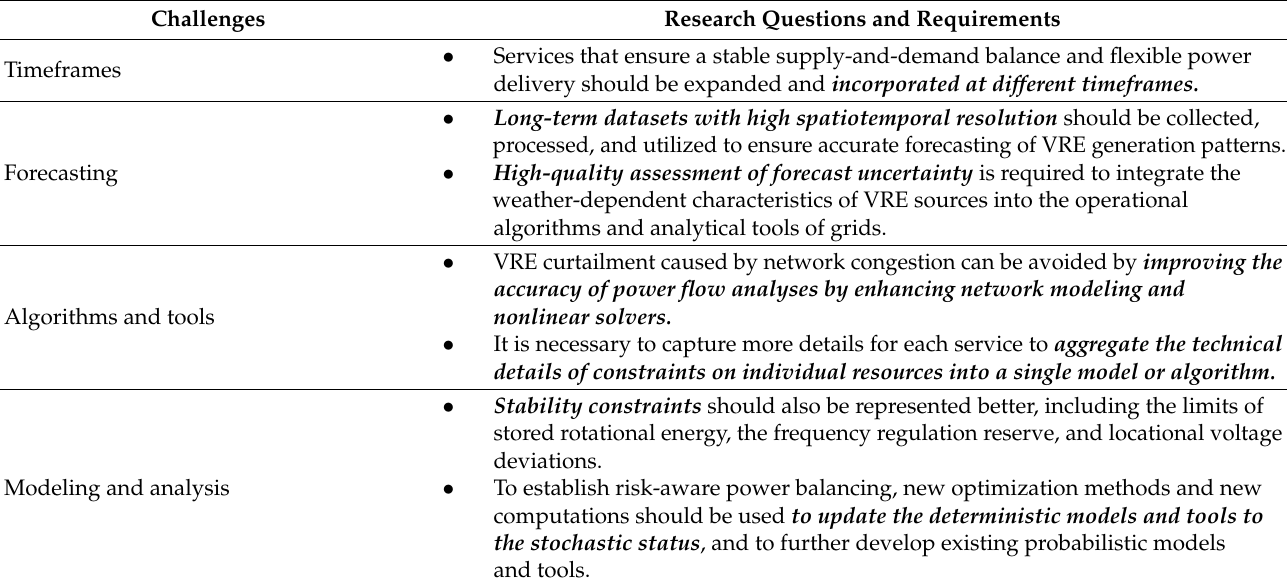
Table 1. List of research challenges in balancing supply and